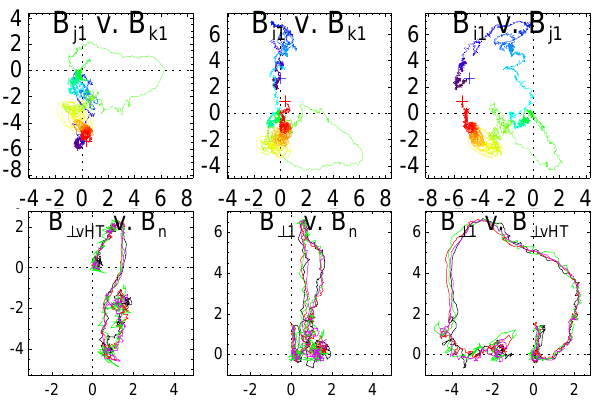
Fig. 4. 2 April 2002 B hodograms; top) C1 in minimum variance coordinates for 04:11:41–04:13:18UT; bottom) all spacecraft, in timing analysis coordinates for 04:12:34–04:12:41UT, with, left to right, r HT × n 4pt , r ⊥ × n 4pt , r ⊥ × r HT . See text for